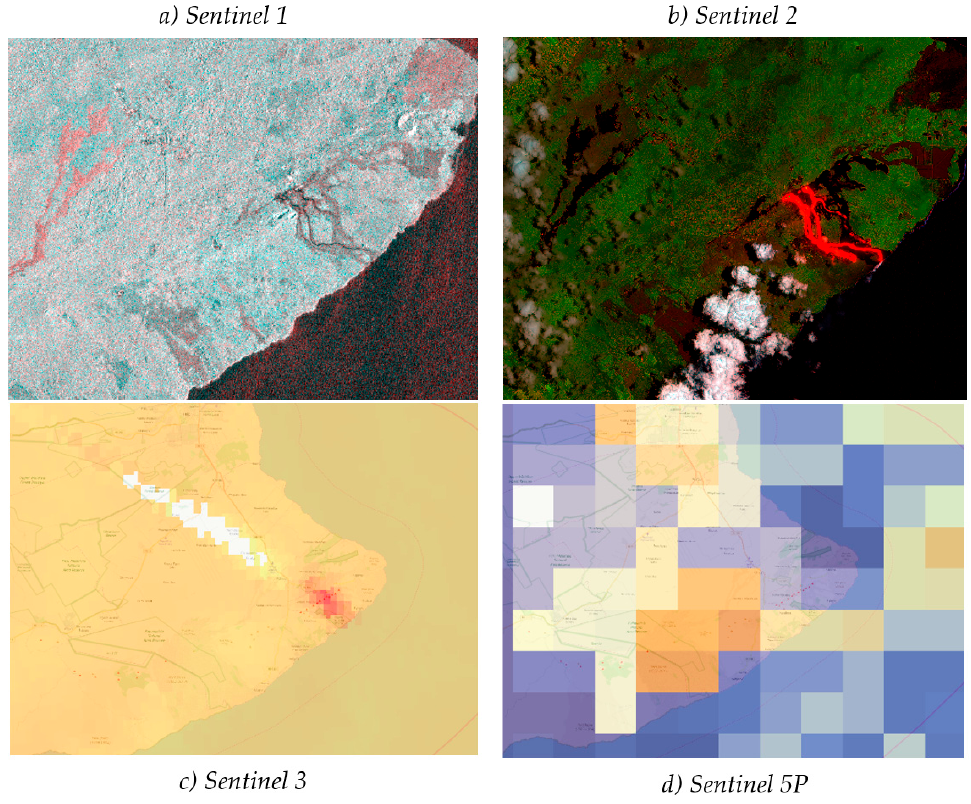
Figure 2. ( a ) Sentinel 1: sensor, Sentinel-1A; resolution: 10 m; date: 23/05/2018; product: composition: VV (vertical transmit and vertical receive), VH (vertical transmit and horizontal receive), VH in RGB (red-green-blue). ( b ) Sentinel 2: sensor, Sentinel-2B; resolution: 10 m; date: 23/05/2018; product: composition bands 11, 8, and 3 in RGB. ( c ) Sentinel 3: sensor, Sentinel-3A; resolution: 1 km; date: 23/05/2018; product: bright temperature (RBT). ( d ) Sentinel 5: sensor, Sentinel-5P; resolution: 7 km; date: 28/06/2018; product: UV Aerosol Index.